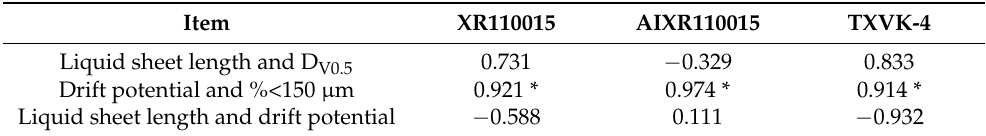
Table 5. Correlation coefficient of the liquid sheet length, %<150 µ m, and the drift potential for the XR, AIXR, and TXVK-4 nozzles. Item XR110015 AIXR110015 TXVK-4 Liquid sheet length and D V0.5 0.731 − 0.329 0.833 Drift potential and %<150 µ m 0.921 * 0.974 * 0.914 * Liquid sheet length and drift potential − 0.588 0.111 −